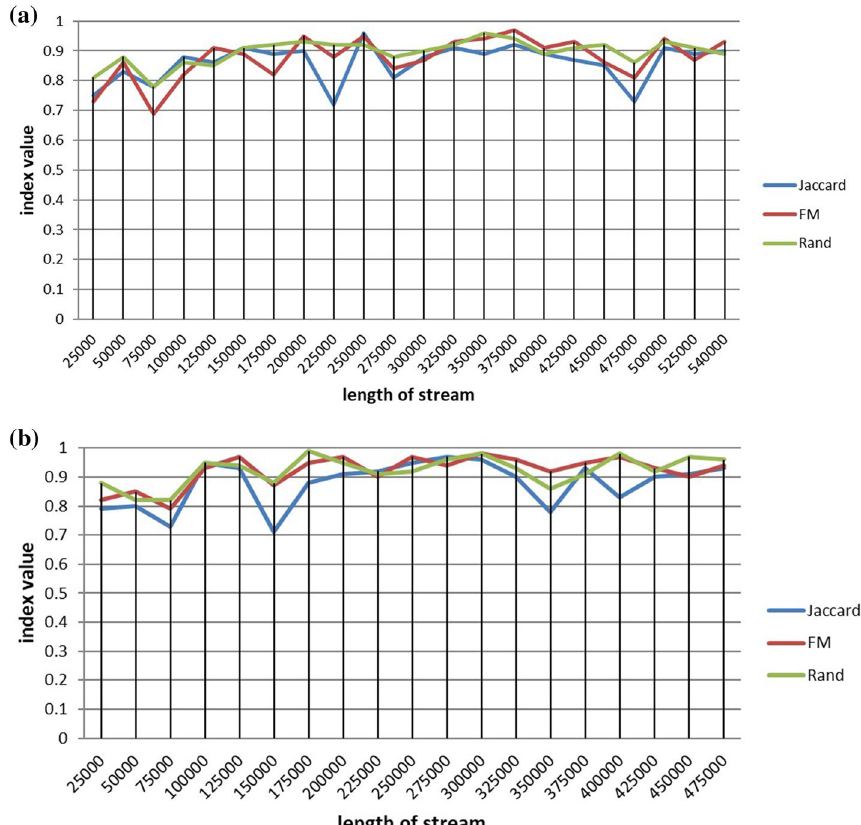
Fig. 17 Reference model: D‑Stream. In the figure 17, the blue, red and green fold were respectively used to record Jaccard, FM and Rand indicators when reference model is D‑Stream. A shows cluster quality in CoverType and B shows cluster quality in KDDCUP99